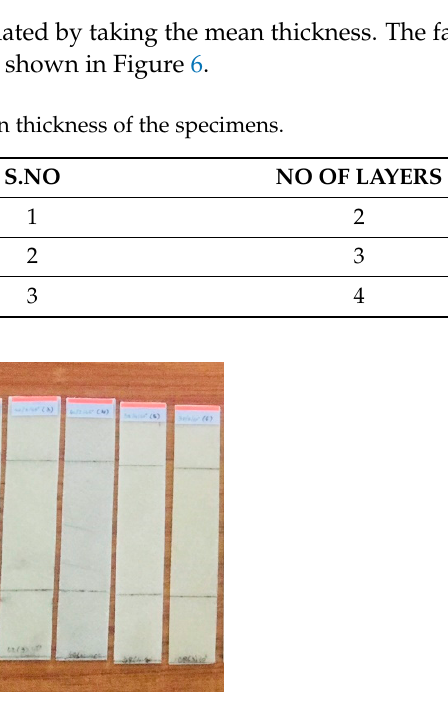
Figure 6. Samples of the woven flax/bio epoxy (WFBE) laminated composite.